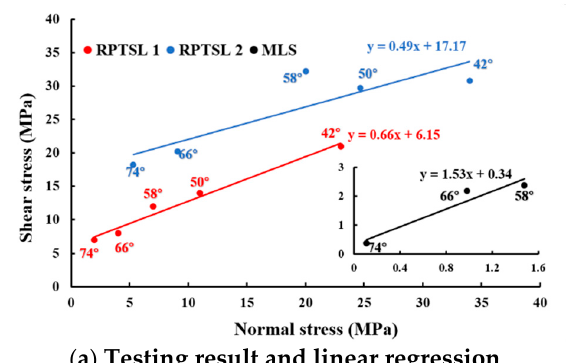
Figure 11. Shearing test result.